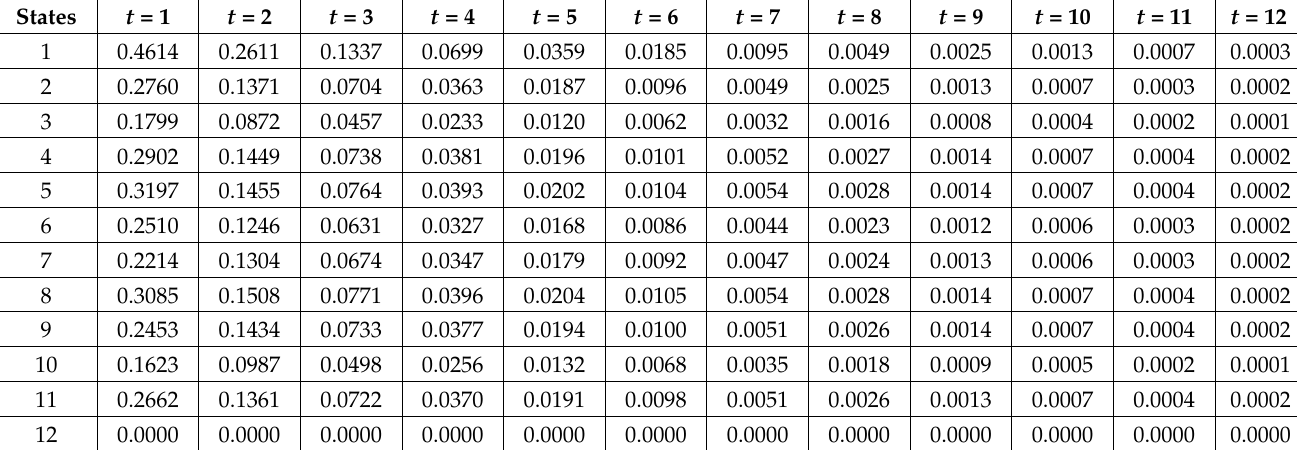
Table 4. Probability matrix f jk ( t ) for j = 1, . . . ,12, k = 12, t = 1, 2, . . . , 12. Source: Authors’ own elaboration.